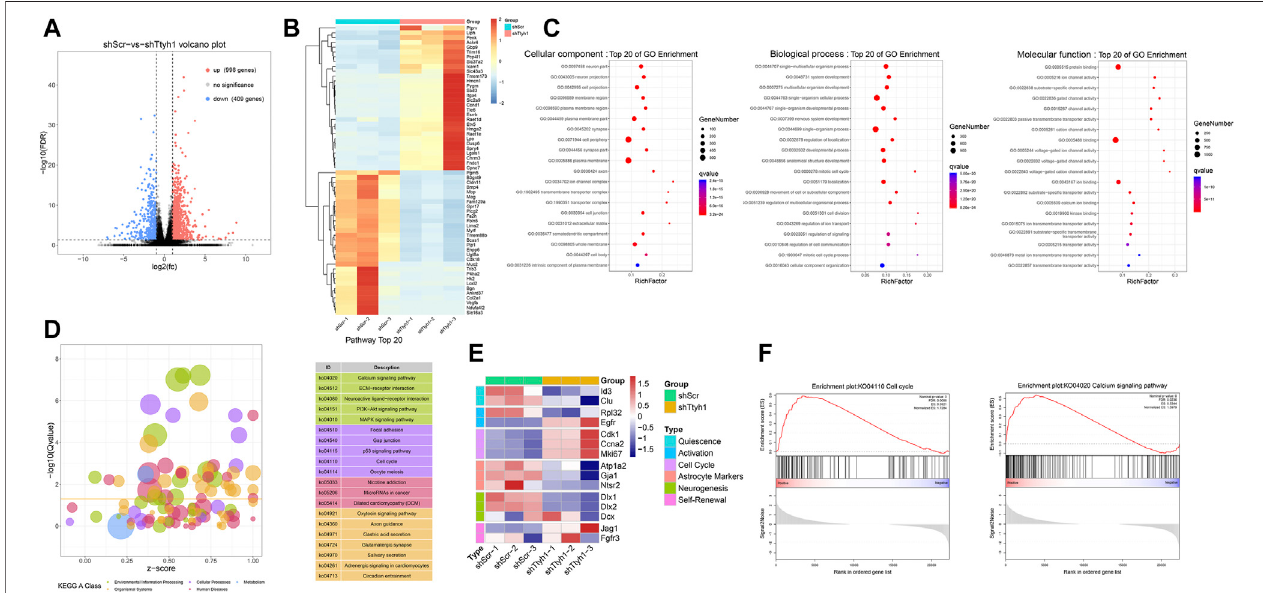
FIGURE 6| Transcriptome sequencing results after Ttyh1 knockdown indicate involvementof Calcium signaling and cell cycle genes. (A) Differential gene volcano plot.Reddotsrepresent998up-regulatedgenes,andbluedotsrepresent409down-regulatedgenes.Weusedfalsediscovery rate(FDR) < 0.05andfoldchange ≥ 2as criteria to screen for genes with signi fi cant differences. (B) Heatmap of the top 30 genes with the most signi fi cant difference in up-regulation and down-regulation, respectively. Among them, cell cycle gene Ccnd1 (Cyclin D1) was signi fi cantly up-regulated in the Ttyh1 knockdown group. (C) Gene Ontology (GO) analysis. Colorsrepresent qvalueson alogscale(withred correspondingtothemosthighly signi fi cant). Nodesizerepresents thenumber ofgenesinacategory.Top20itemsof q value are listed. (D) KEGG pathway analysis. The vertical coordinate is − log10 (q value), and the horizontal coordinate is Z-score value (the proportion of the difference between the number of up-regulated genes and the number of down-regulated genes in the total differential genes), and the yellow line represents the threshold of p (cid:2) 0.05. On the right is a list of signal pathways with the top 20 p -values, with Calcium signaling mostly signi fi cant. Different colors represent different categories. Green represents environmental information processing, purple represents cellular processes, red represents human diseases, yellow represents organismal systems, and blue represents metabolism. (E) Heatmap of stage-speci fi c markers of NSCs between control and Ttyh1 knockdown groups. (F) GSEA (gene set enrichment analysis). After Ttyh1 knockdown, calcium signaling pathway and cell cycle related genes were